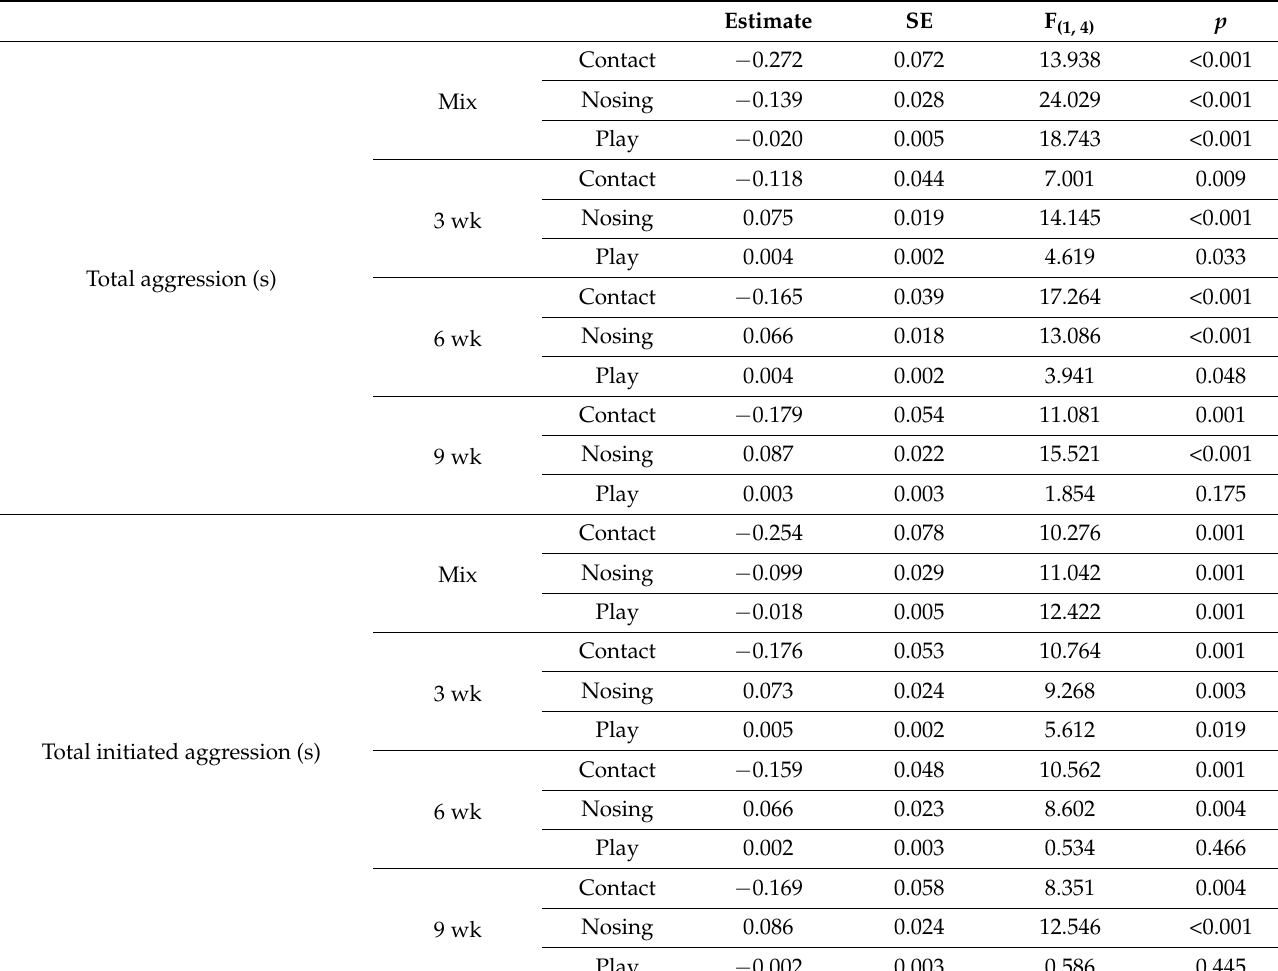
Table 2. Behaviors of non-agonistic contact (proportion of time in non-aggressive contact with unique pigs at each time point), duration of nosing (seconds (s)) (scaled to adjust for differences in measurement between behaviors), and duration of play (s) were compared to total duration of aggression (s) and total duration of initiated aggression (s) at four time points: immediately after mixing, and 3, 6, and 9 weeks (wk) after mixing. Comparisons were made using linear mixed models. Estimate SE F (1, 4) p Contact − 0.272 0.072 13.938 <0.001 Nosing − 0.139 Mix